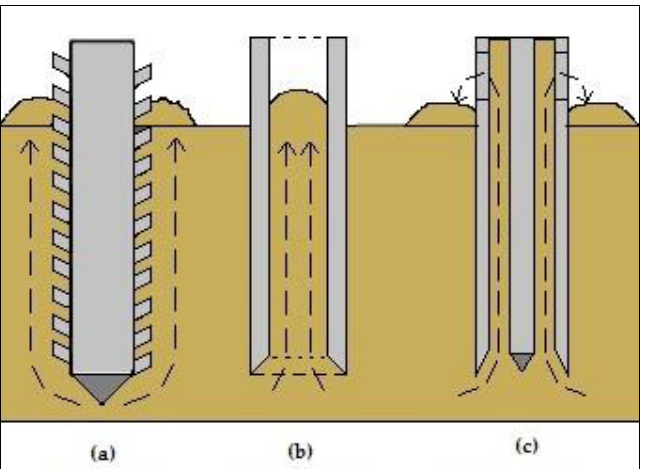
Figure 3. Common types of conventional drilling: ( a ) auger drilling; ( b ) coring drilling; ( c ) pneumatic drilling.